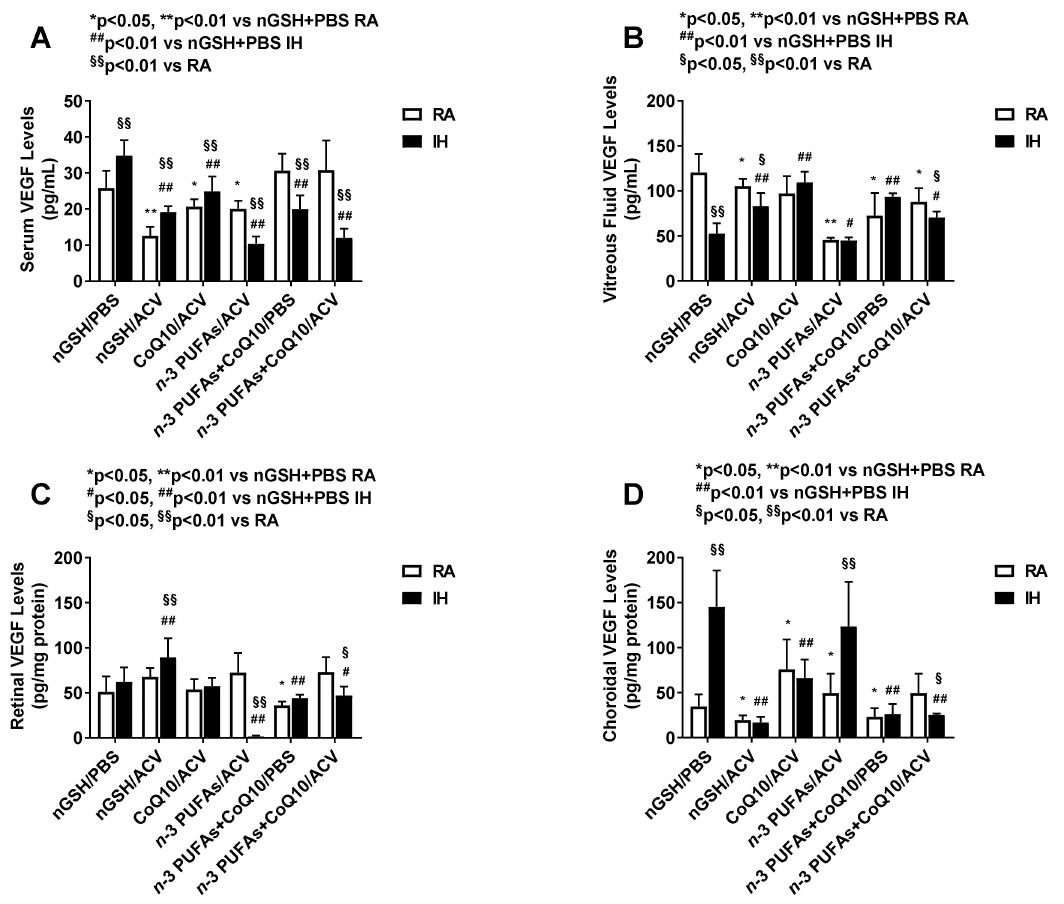
Figure 2. E ff ects of combination treatments on vascular endothelial growth factor (VEGF) levels in the serum ( A ), vitreous fluid ( B ), retina ( C ), and choroid ( D ). Levels in the retinal and choroidal homogenates were standardized using total cellular protein levels. The open bar represents the room air (RA) groups and the solid bar represents the IH groups. Data are expressed as mean ± SD ( n = 6 samples / group for serum; and n = 4 samples / group for vitreous fluid, retina and